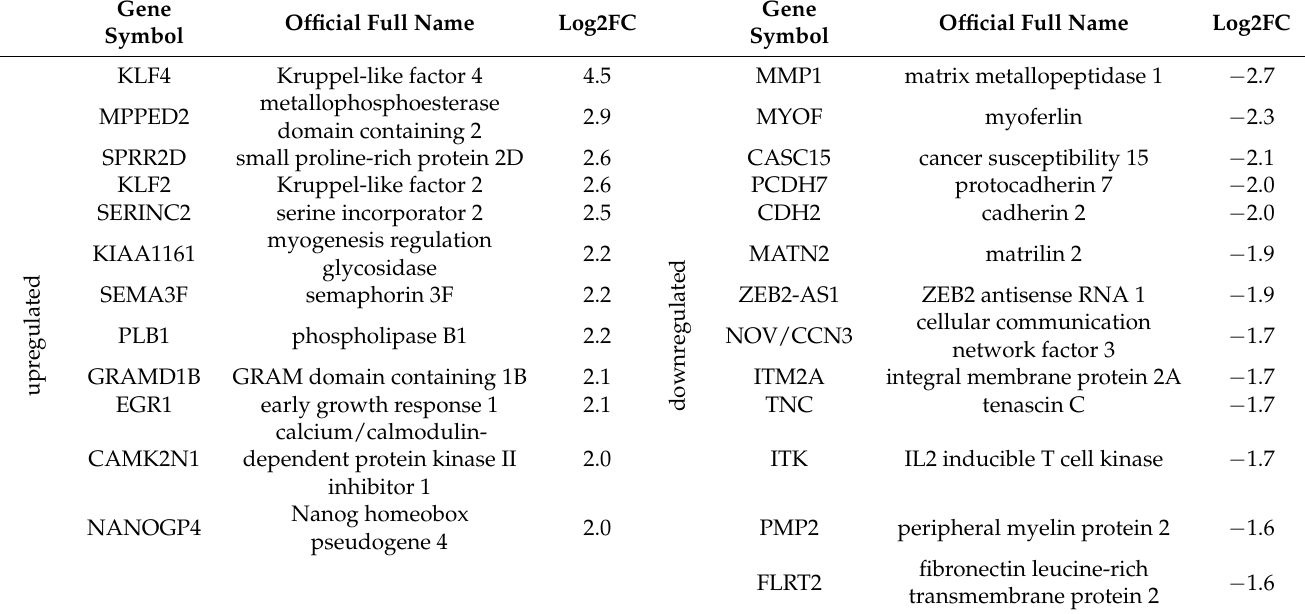
Table 2. Most significantly differentially regulated genes in Mel Im cells cultured in 3D alginate (“upregulated”) compared to 2D (“downregulated”).